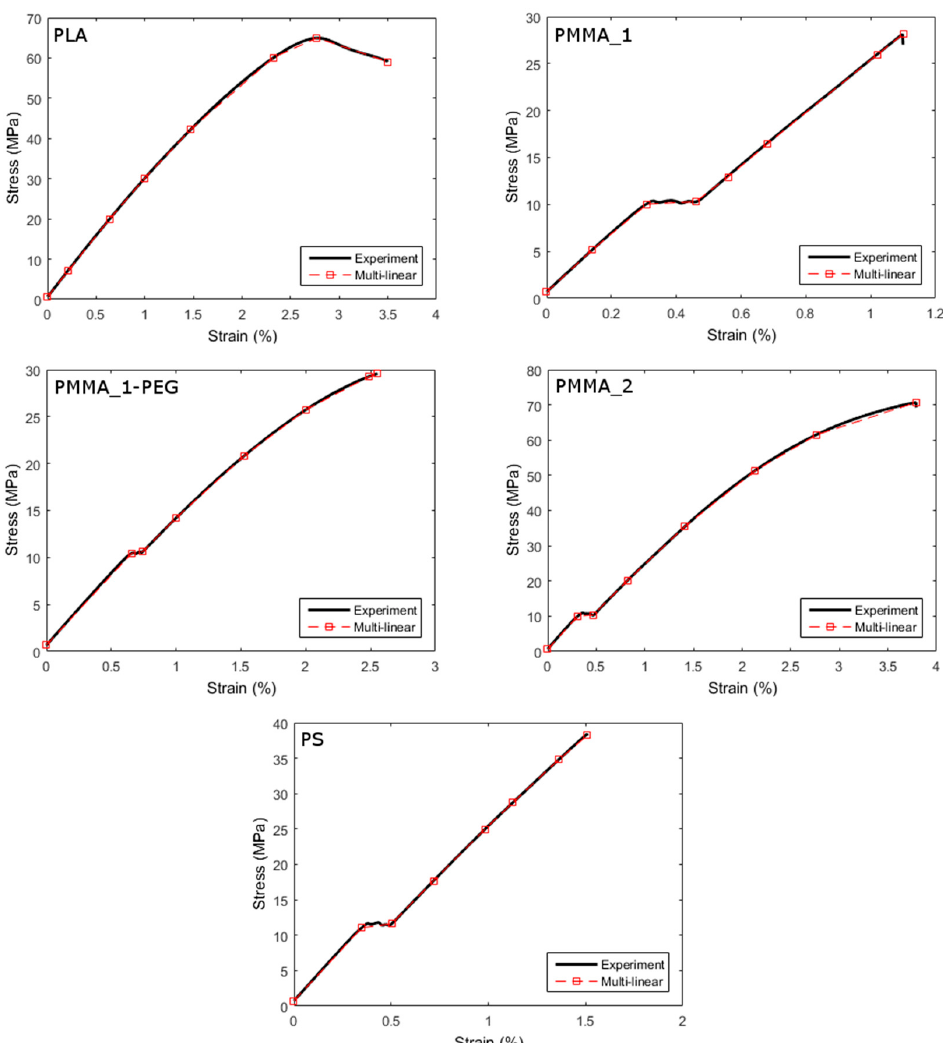
Figure 6. Experimental and schematized stress/strain relationships of encapsulation materials.